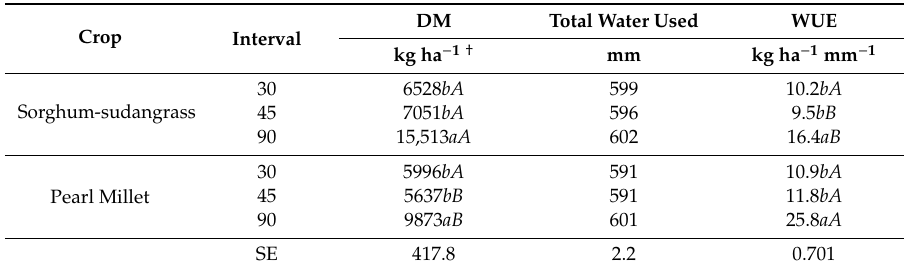
Table 3. Water use e ffi ciency (WUE), dry matter (DM), and total water use means of brown midrib (BMR) sorghum-sudangrass and BMR pearl millet under three di ff erent harvest intervals (three 30-d, two 45-d, and one 90-d) near Canyon, TX in 2017.